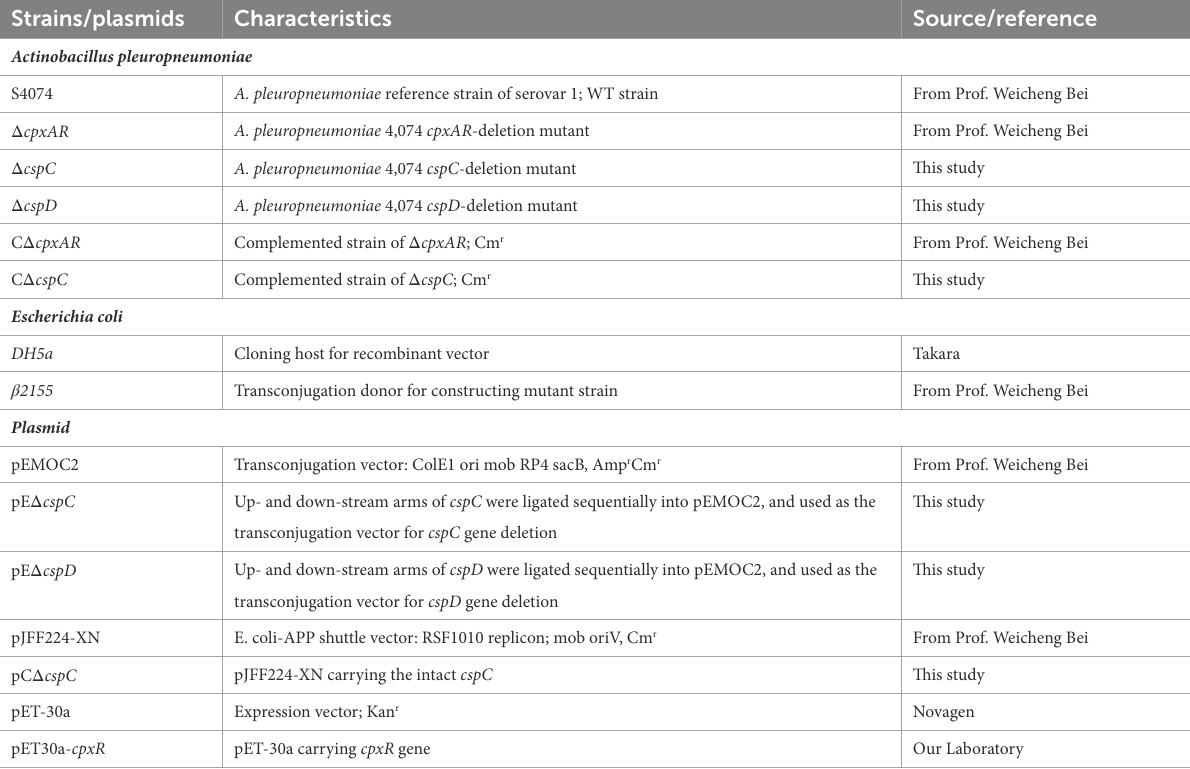
TABLE 1 Bacterial strains and plasmids used in this